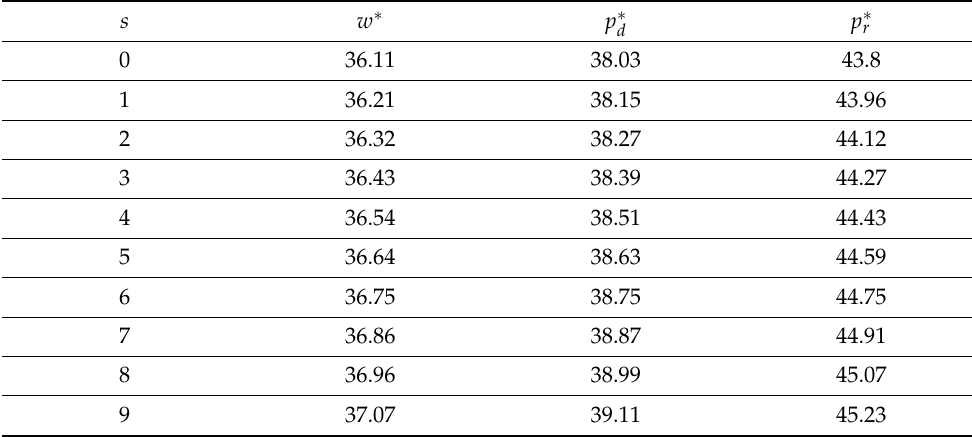
Table 2. The optimal decision under different government subsidies.